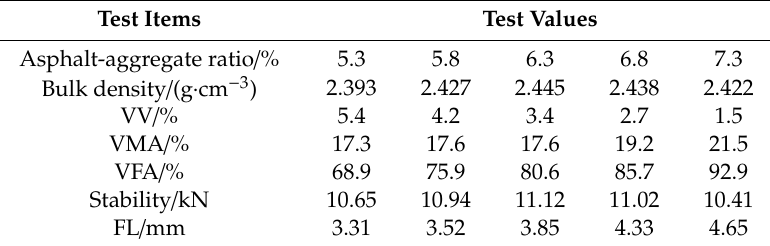
Table 6. Marshall test results of SMA-II-1.